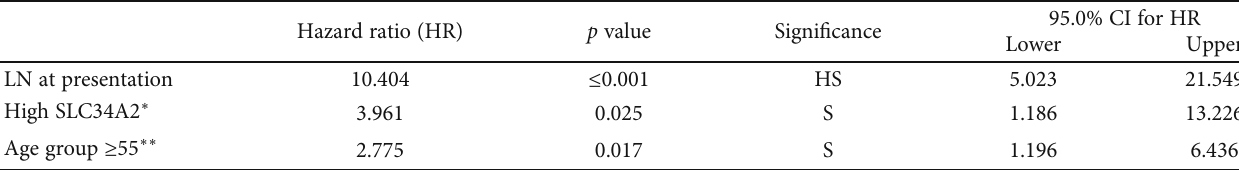
Table 4: Backward Cox regression analysis of important factors a ff ecting